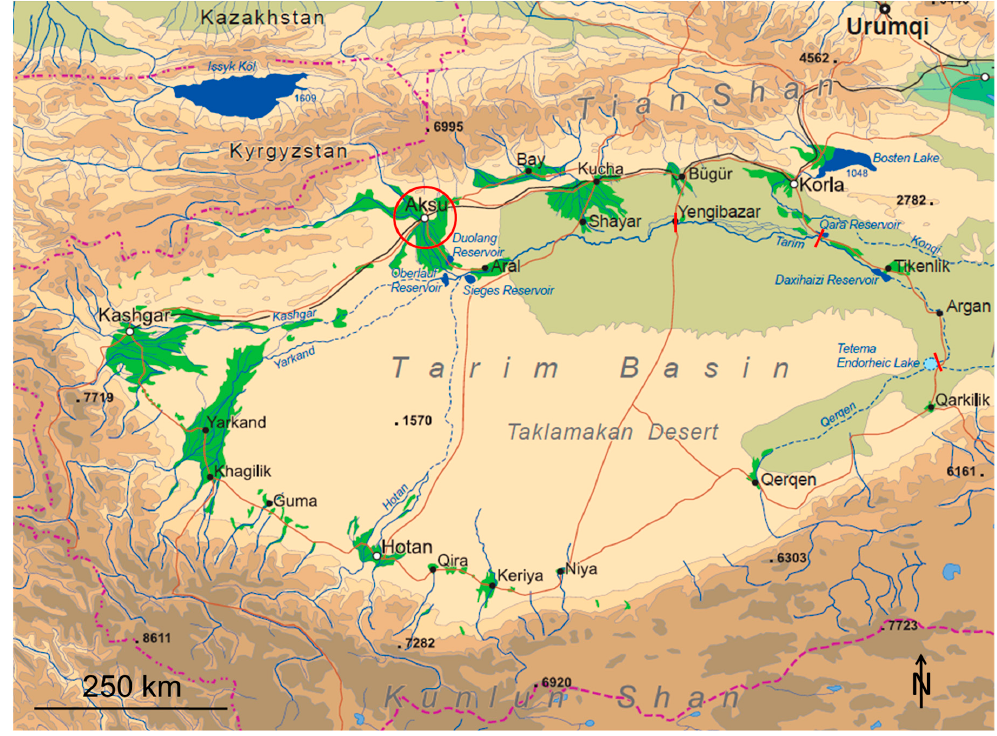
Figure 1. Tarim Basin. Highlighted in red are Aksu City with its surrounding oasis, and the middle and lower reaches of the Tarim River. Adapted from [19]; river section markings adapted from [20]. The longest river, the Tarim River, forms at Aral as a junction of Yarkant River, Hotan River, and Aksu River. It then flows over 1000 km eastward to the reservoir Daxihaizi where it ends in the desert [21] (cf. Figure 1). Due to a low gradient and high sediment loads, it meanders heavily,